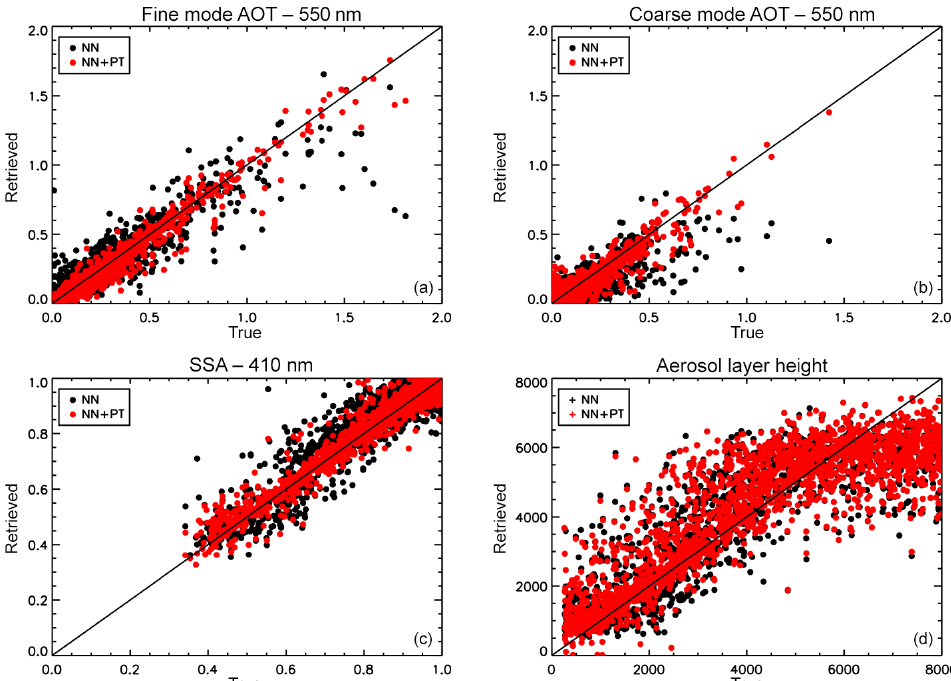
Figure 9. Plots of retrieved versus true fine-mode AOT (a) , coarse mode AOT (b) , SSA at 410nm (c) and aerosol layer height (d) for the neural network (NN) and the Phillips–Tikhonov algorithm using the neural network results as a first guess (NN–PT), on a sample of 4798 synthetic test cases. Statistics are given in Table 3.